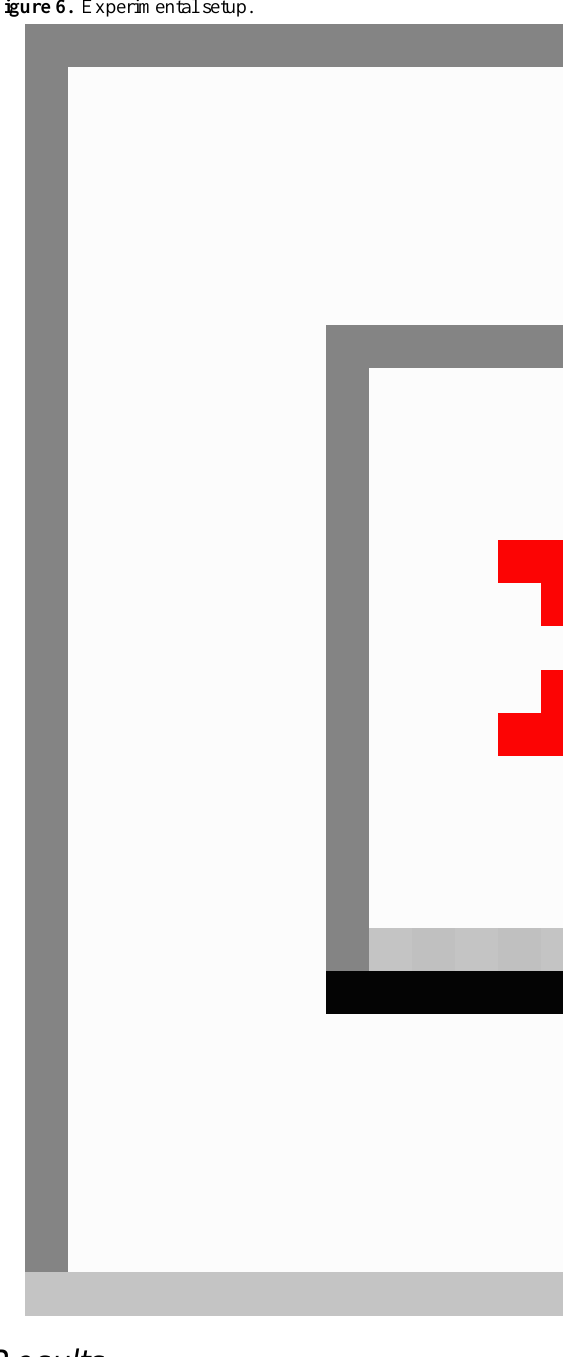
Figure 6. Experimental